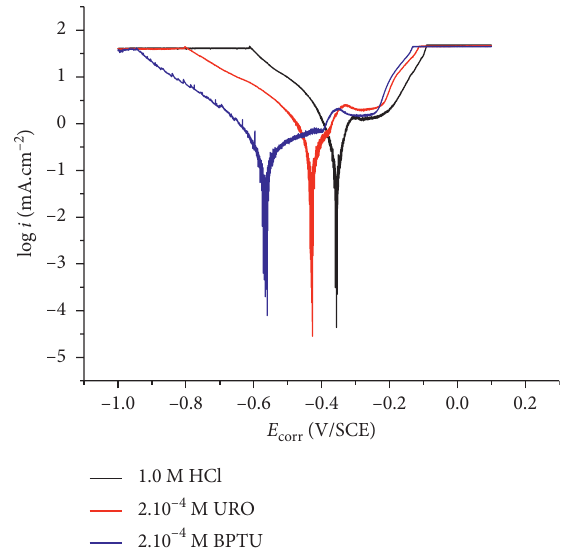
Figure 7: Potentiodynamic polarization curves of mild steel in 1.0M HCl in the presence of BPTU and URO at 30 ° C.